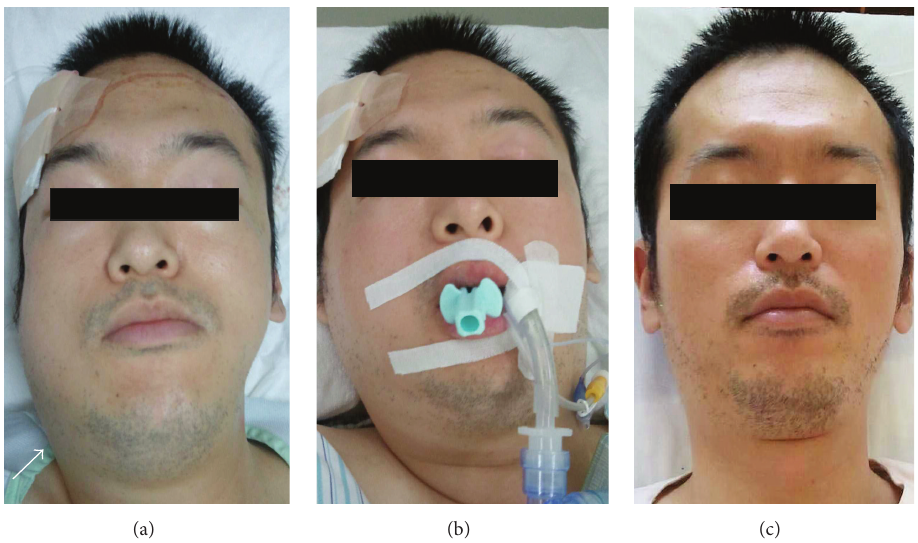
Figure 3: (a) Swelling of the right submandibular lesion (arrow) at 7 hours after operation. (b) Two days after operation, swelling of the submandibular lesion is still apparent. (c) The glandular swelling had almost disappeared by the fifth postoperative